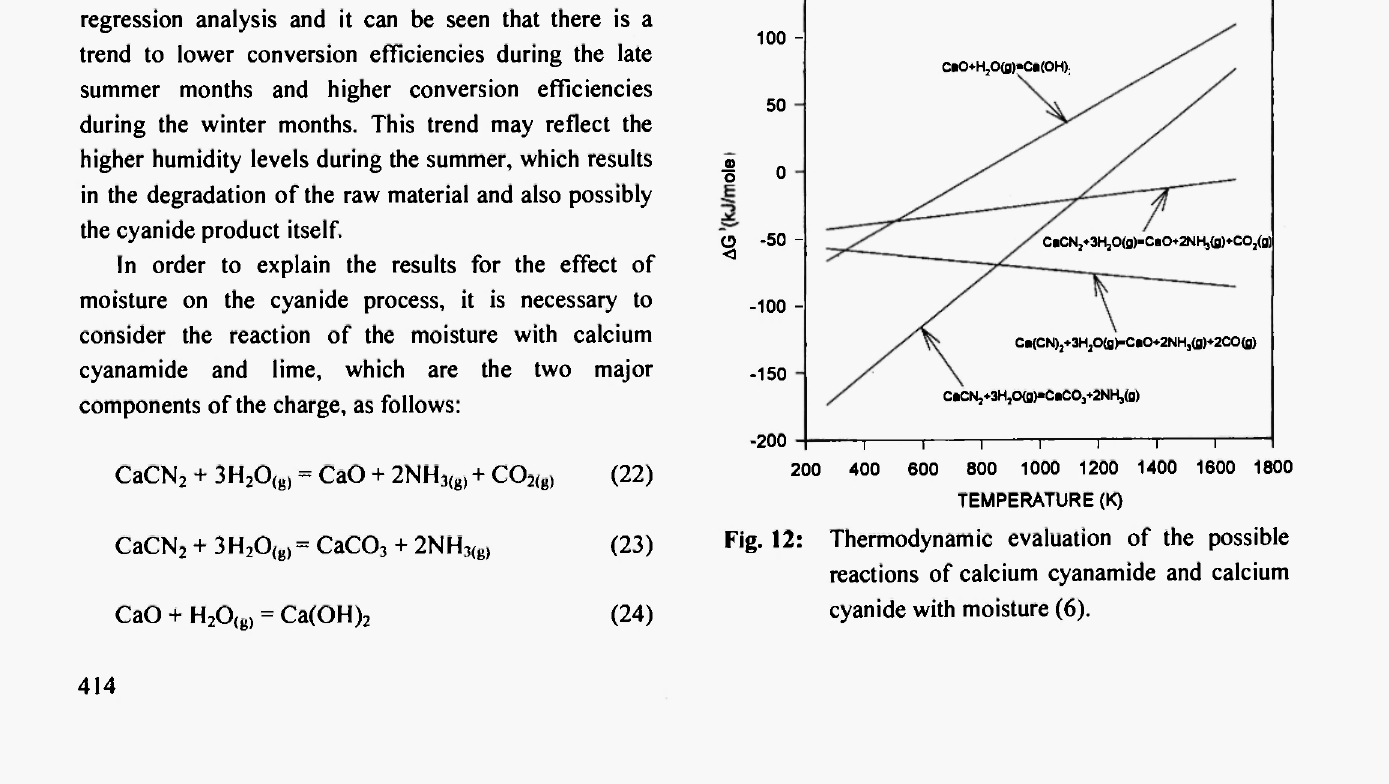
Fig. 12: Thermodynamic evaluation of the possible reactions of calcium cyanamide and calcium cyanide with moisture